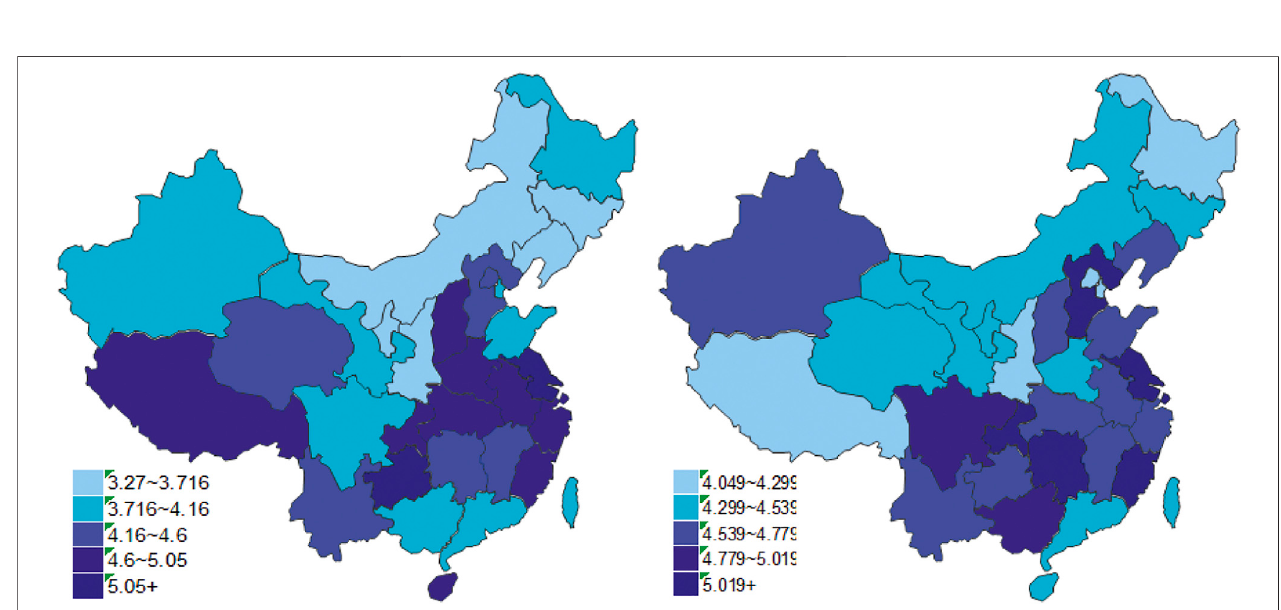
FIGURE 5 | The comparison of average network degree between 2011 and 2019.